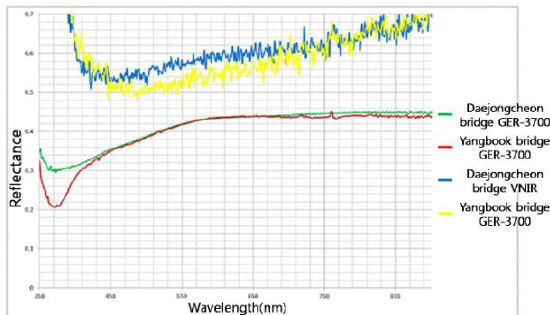
Figure 12. Reflectance spectra of two concrete structures measured by GER-3700 and VNIR